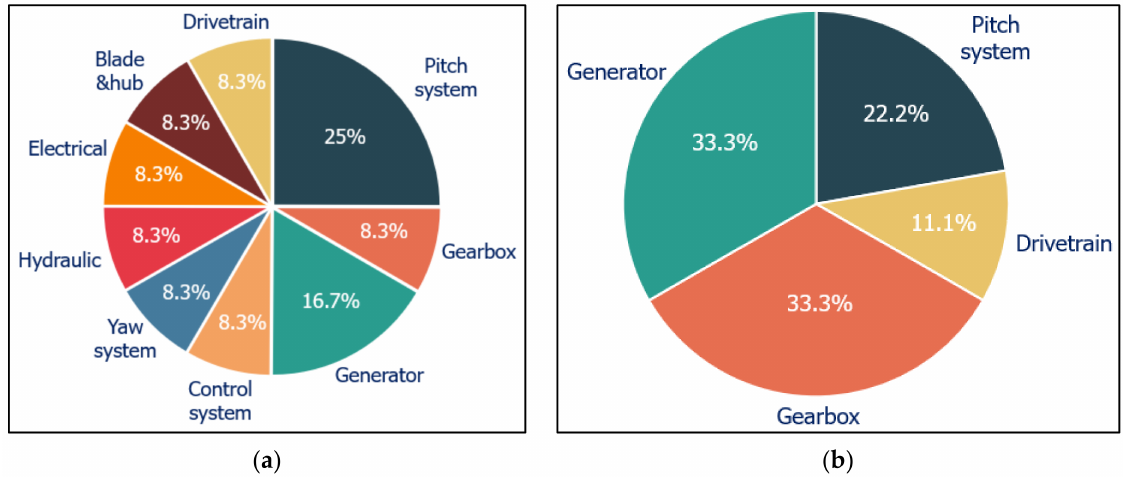
Figure 2. Failure rates and downtime rates of offshore wind turbine components: ( a ) each compo- nent’s share of the total failures; ( b ) each component’s percentage of the total downtime.